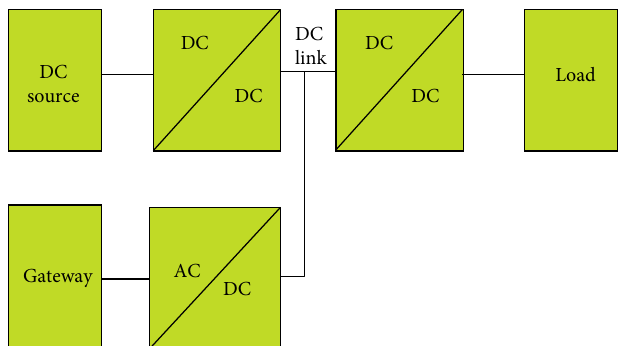
Figure 11: The basic block diagram of nanogrid comprising DC. Table 2: Voltage and power for a number of PV units.